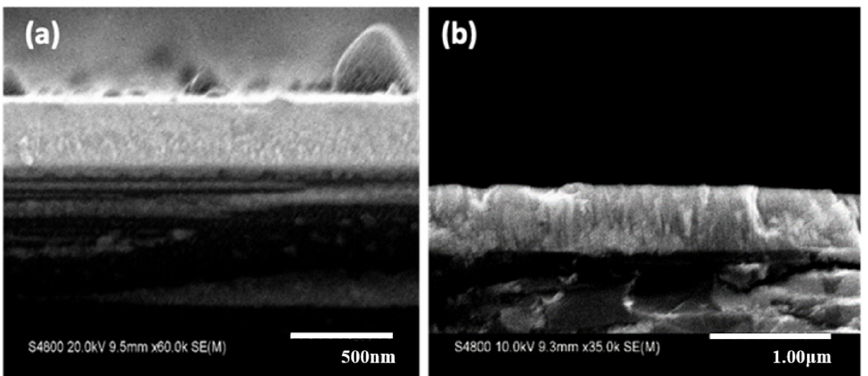
Figure 3. Cross-sectional SEM images of ScYSZ prepared at ( a ) T s = 25 ◦ C ( a , b ) T s = 800 ◦ C, with P O = 0.1 Pa, 3 h deposition time on SiO 2 -Si substrate.